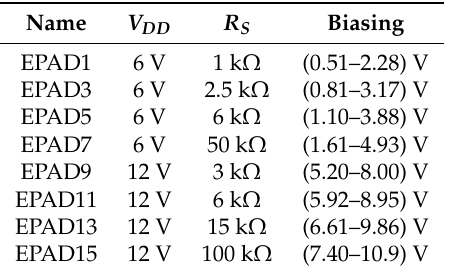
Table 2. EPADs with dynamic bias during irradiation.